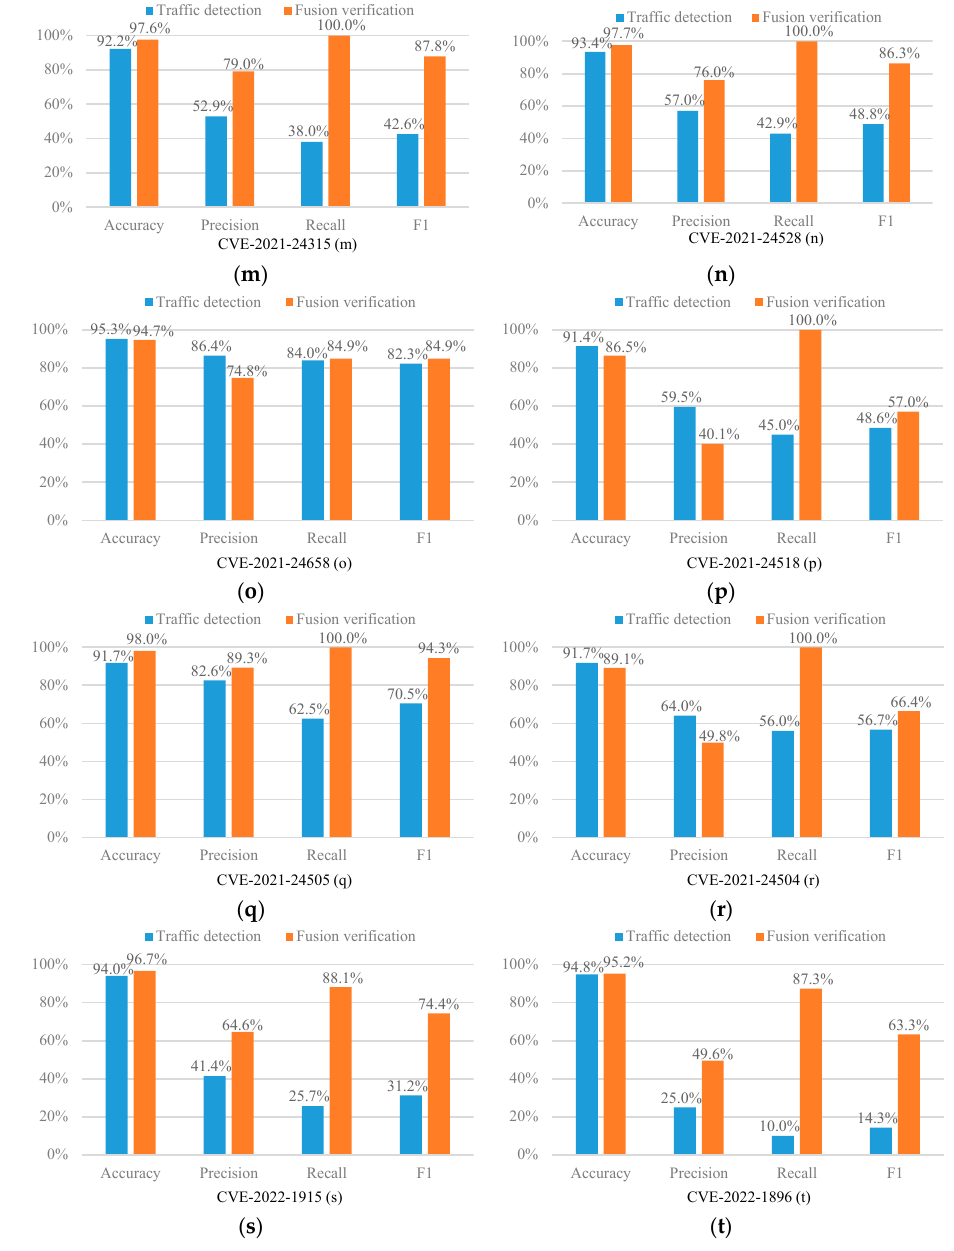
Figure 2. Experimental results ( a – t ).